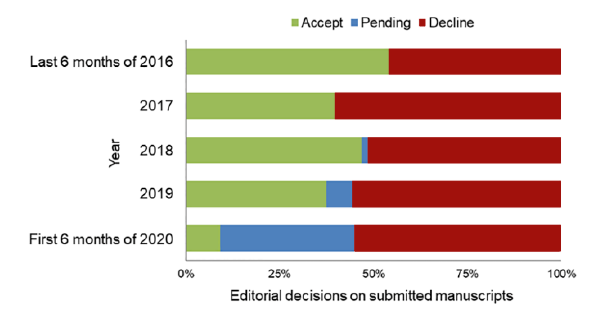
Figure 2 Percentage of submitted manuscripts that are accepted, declined, or pending an editorial